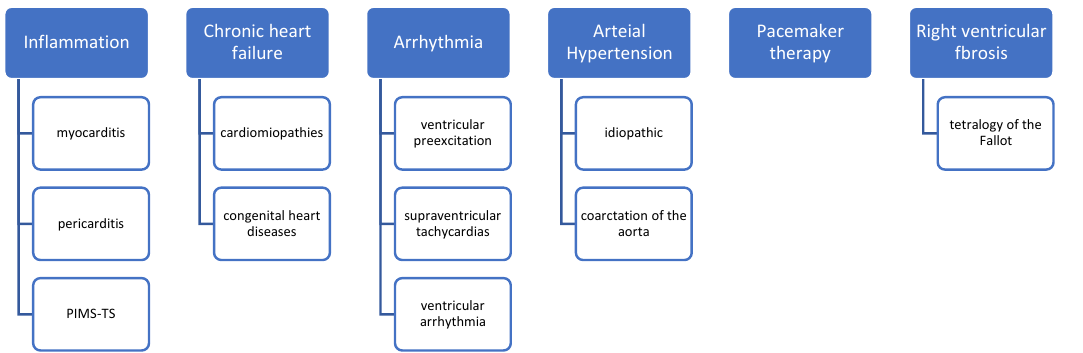
Figure 3. Future research directions for galectin-3 in pediatric cardiology. PIMS-TS: pediatric inflam- matory multisystem syndrome temporally associated with SARS-CoV-2.